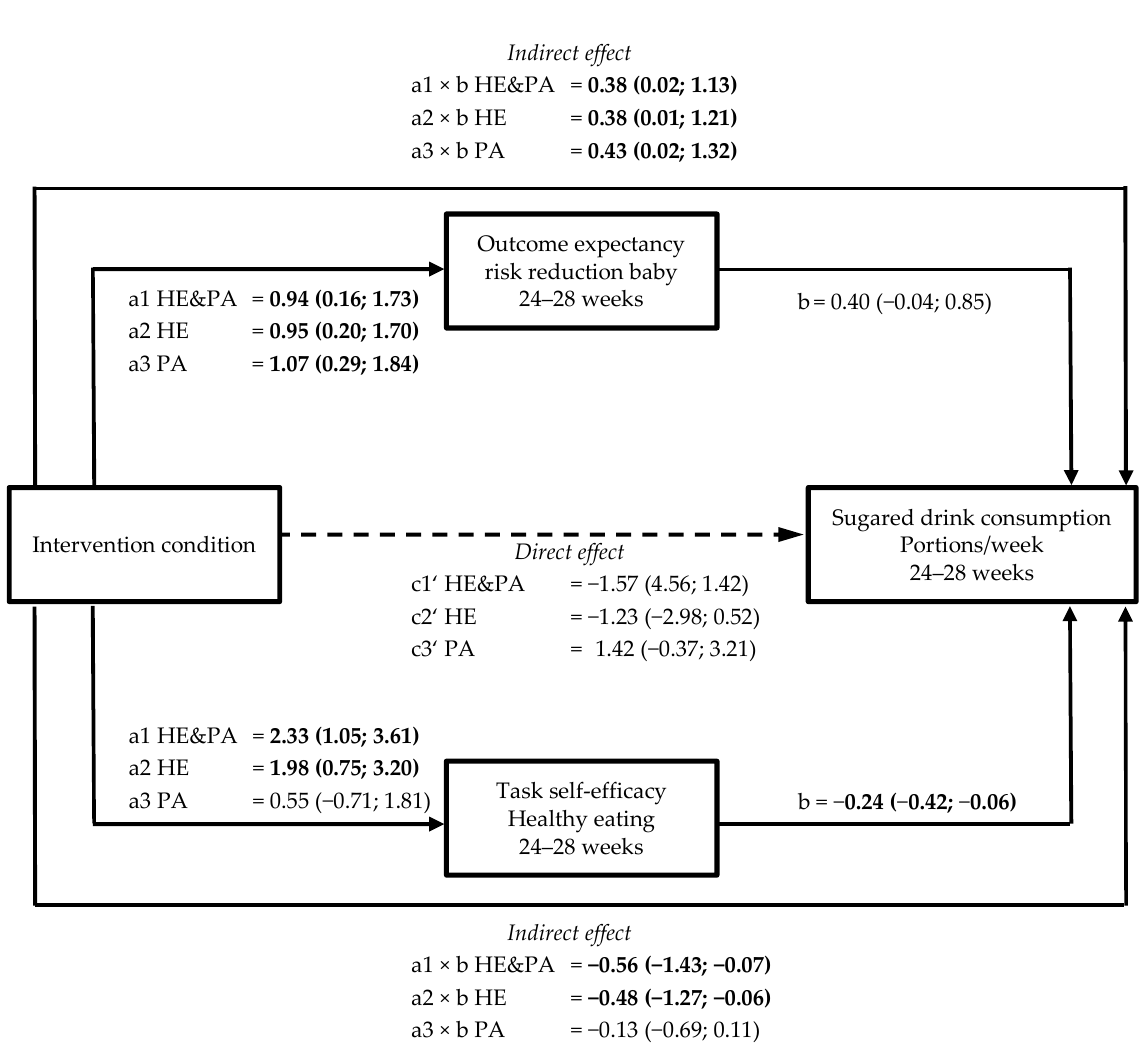
Figure 2. Schematic diagram of the results of mediation by outcome expectancy and task self-efficacy on sugared drink consumption. Shown are the path coefficients between intervention condition, outcome expectancy of risk reduction for the baby, and task self-efficacy at 24–28 weeks, and sugared drink consumption at 24–28 weeks. Statistically significant path coefficients are shown in bold and with solid lines. Dashed lines indicate non-significant paths. Indirect effects were calculated as the product of the coefficients of the a and b paths (a × b).